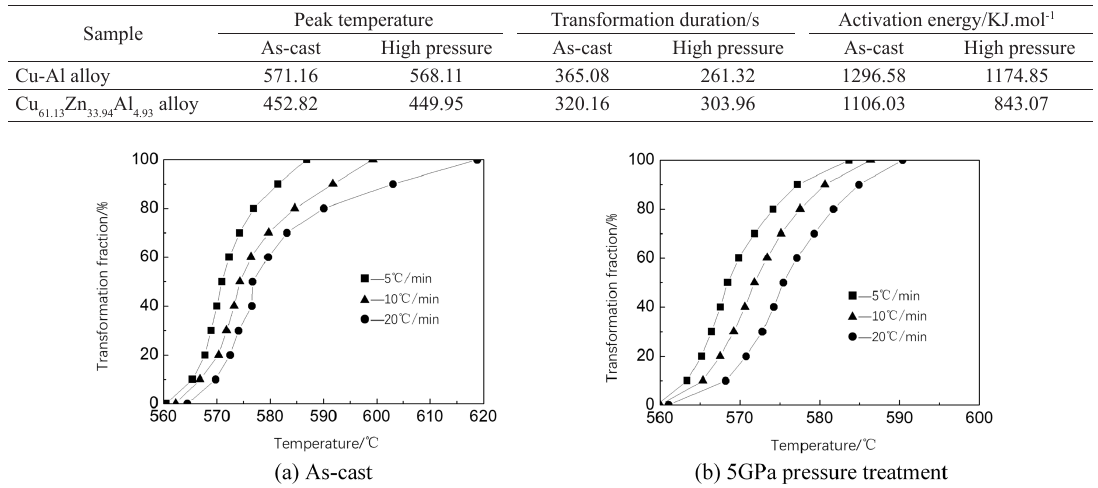
Zn Al alloy before and after 61.13 33.94 4.93